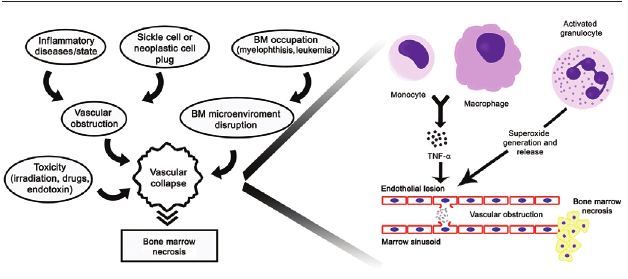
figurE 1 − BMN pathophysiology: inflammation and plugs of sickle cells or neoplastic cells cause vascular obstruction and disrupt oxygen/nutrient delivery to hematopoietic tissue. BM infiltration (for example, by leukemic cells) can provoke microenvironment imbalance, as does cytotoxicity induced by irradiation, or drugs – either can cause vascular collapse –. TNF- α produced by monocytes and macrophages, and superoxide released by granulocytes, induce endothelial lesions with platelet aggregation, and vascular obstruction. All of these events can lead to BMN BMN: bone marrow necrosis; TNF- α : tumor necrosis factor alpha; BM: bone marrow.